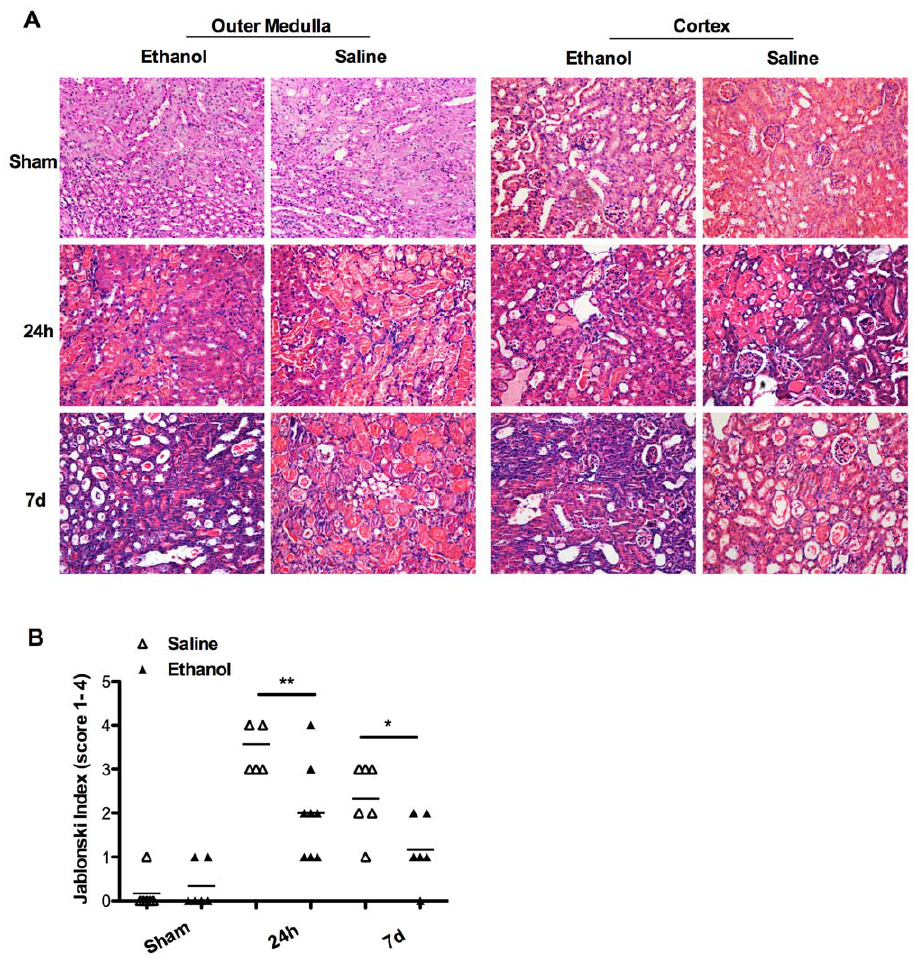
Figure 3. Ethanol pretreatment attenuated tubular damage after renal IR. Mice were pretreated with saline or 1 g/kg ethanol, and were exposed to a 30-min bilateral renal IR 3 h later. Kidney samples were collected at 24 h post reperfusion and assessed for: A. H&E staining of renal outer medulla (left panel) and cortex (right panel). Sections are representative of 6–8 independent mice per experimental group (200 6 original magnification). B. Scoring of the tubular injury according to the Jablonski’s criteria. (* p , 0.05, ** p , 0.01).